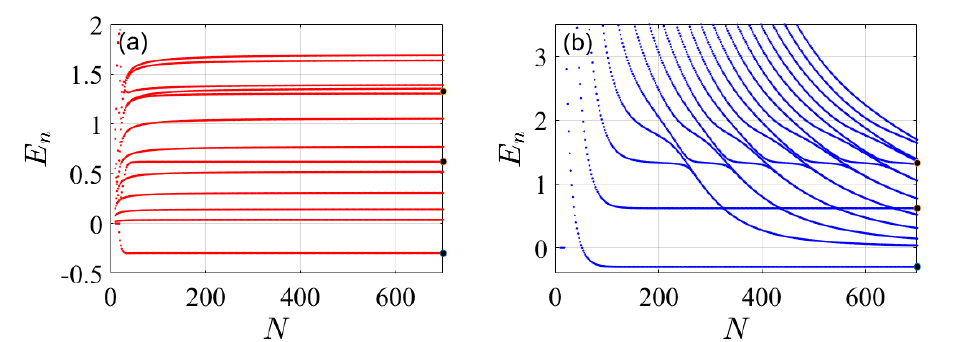
Figure 5. Stabilization graphs for the ( a ) standard (non-variational) and ( b ) present (variational) finite difference methods. The plots show the spectrum, E n ; n = 1,2, . . ., as a function of the number of grid points N for a model potential V r ( x ) , Equation (8). The full dark points on the right hand side indicate the exact values of the bound and the two nearest resonance energies as calculated by the uniform complex scaling approach. Both methods lead to accurate values as N increases, however, in the standard method, Panel ( a ), does not allow to distinguish between the resonances and the other quasi-discrete continuum states. In contrast, the variational principle of the present FDM leads to a typical stabilization graph. The stability of the metastable states in the continuum enables identifying them. Their positions (i.e., energies) is determined by the stable region. Model parameters: δ x = L max / N max ≈ 8.5 × 10 − 2 , L max = 60 and N max = 700. These numerical